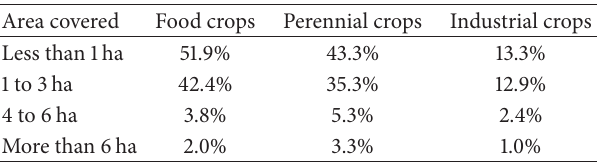
Table 3: Agricultural field areas used by interviewed households by type of crops